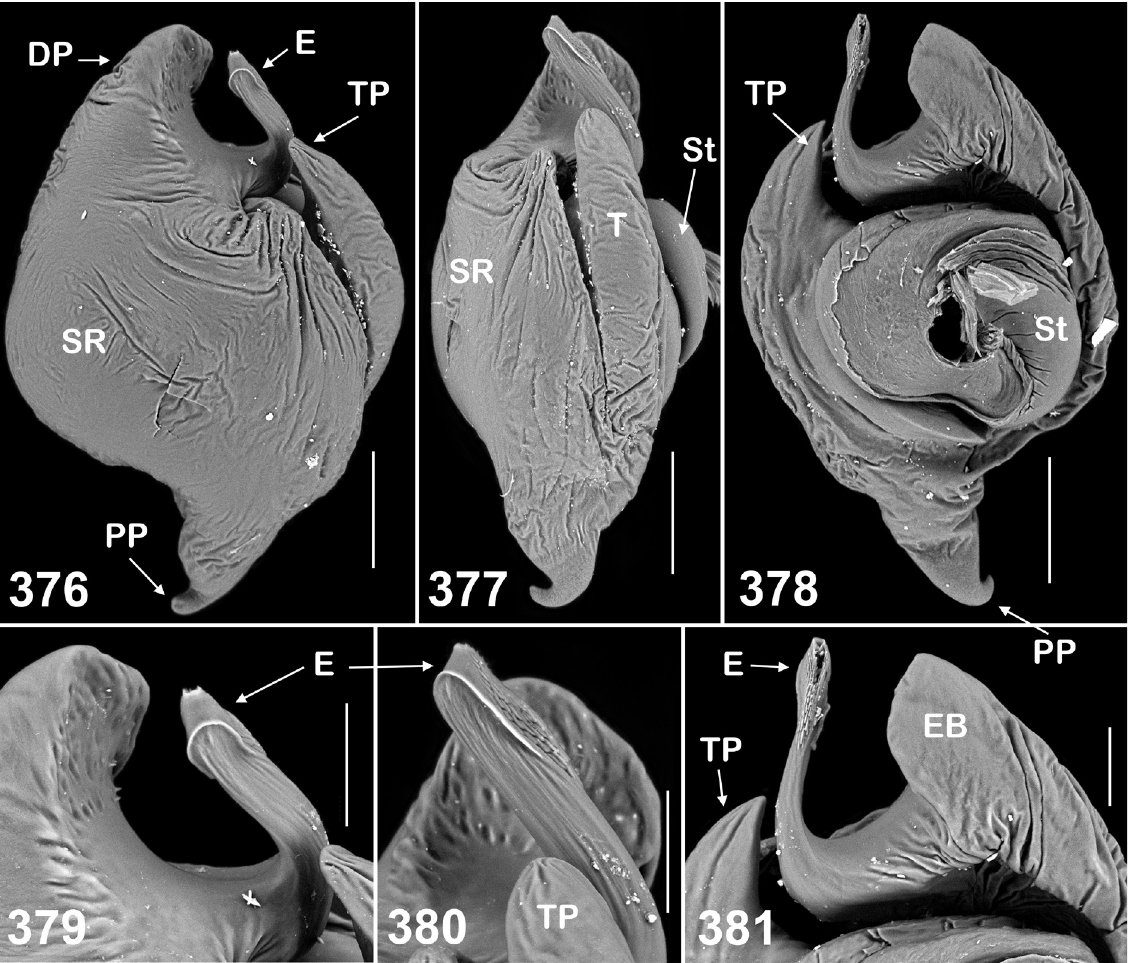
Figs 376–381. Stenaelurillus nigricaudus Simon, 1886, from Senegal (Richard Toll), scanning electron micrographs. 376 . Bulbus of male palp, ventral view. 377 . Male palp, retrolateral view. 378 . Male palp, dorsal view. 379 . Embolic division, ventral view. 380 . Embolic division, retrolateral view. 381 . Embolic division, dorsal view. Abbreviations: see Material and methods. Scale bars: 0.1